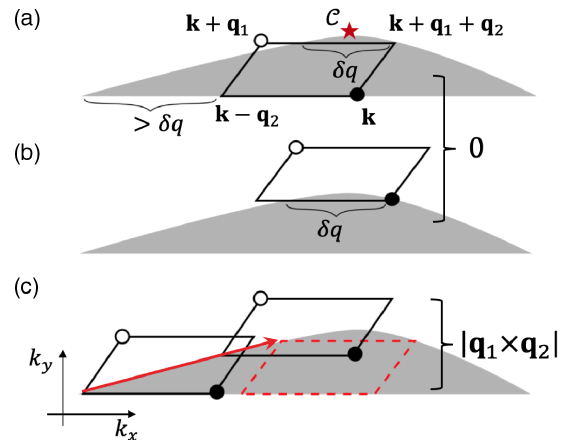
FIG. 12. Configurations of the integrand, represented as a parallelogram P , contributing to the density correlation when placed near a Fermi surface critical point C . (a) – (c) show dif- ferent possible locations for P . As argued in the text, each convex or concave critical point [with v sgn ð q 1 ] contributes (cid:4)j q 1 × q 2 j to the integral, leading to the y Þ q q χ 1 × 2 j dependence of s 3 ð F j